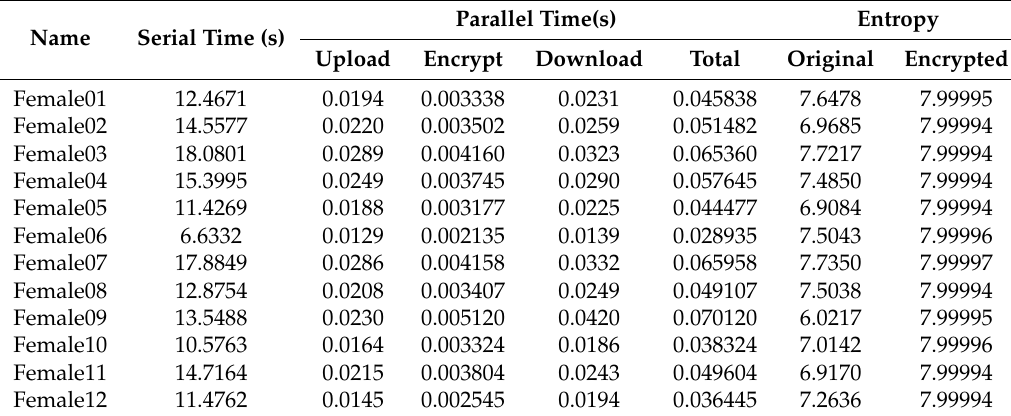
Table 2. Female dataset encryption results.